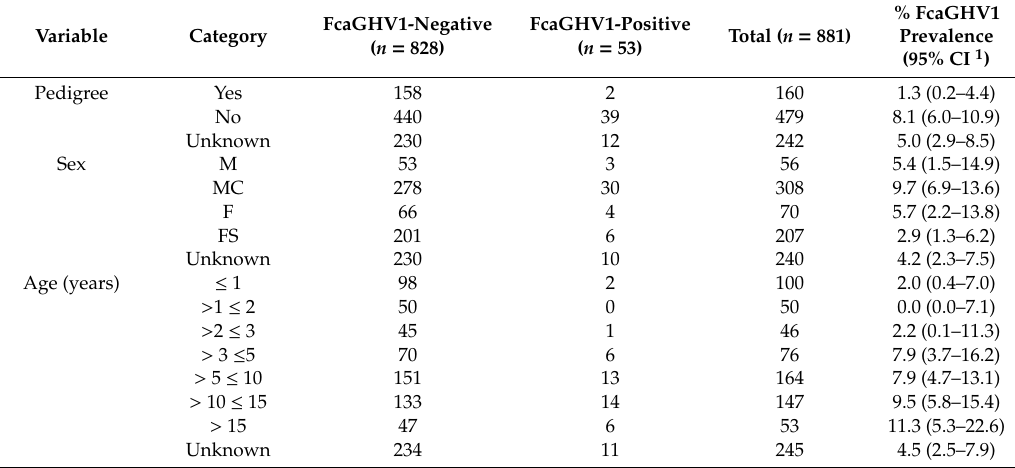
Table 3. Sample characteristics of the 881 cats in the Swiss prevalence study and the FcaGHV1 molecular prevalence